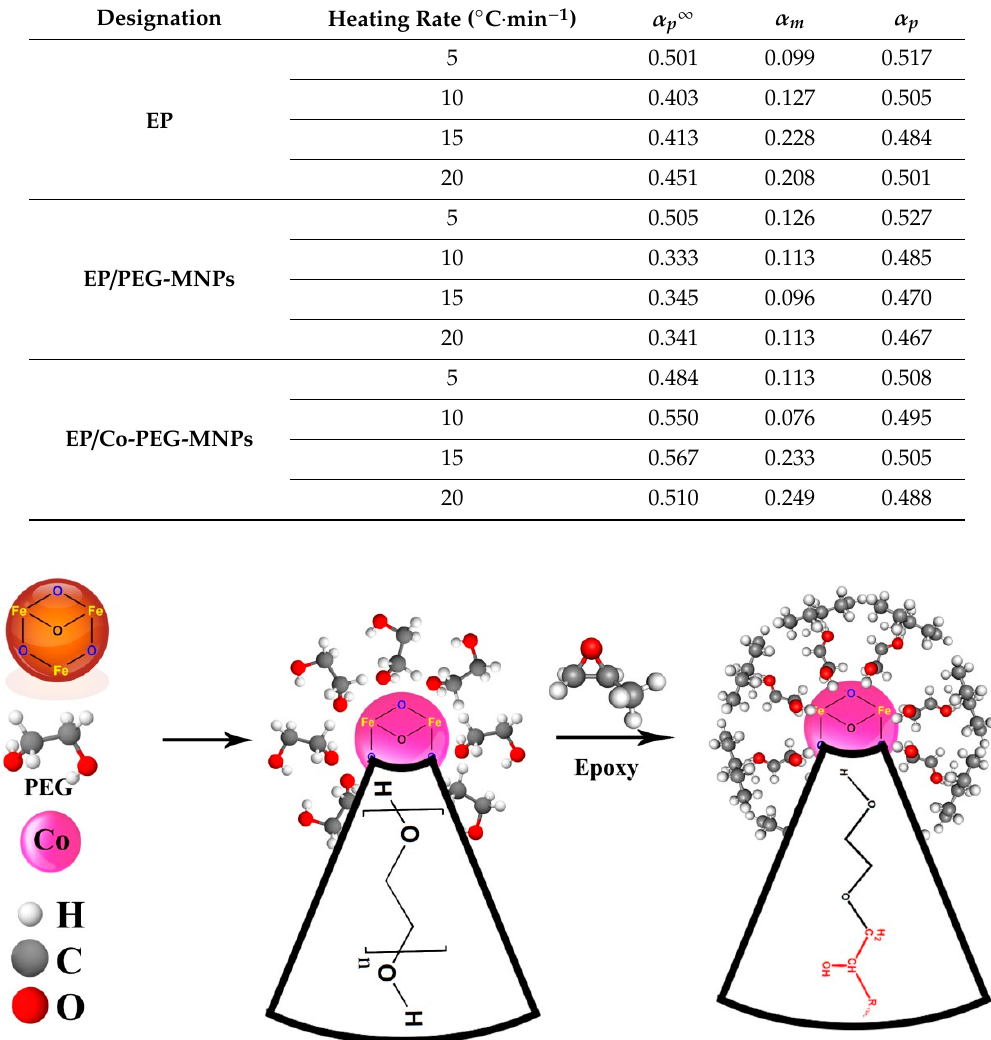
Table 2. The quantities of α p , α m and α p ∞ due to Malek model as a function of heating rate.